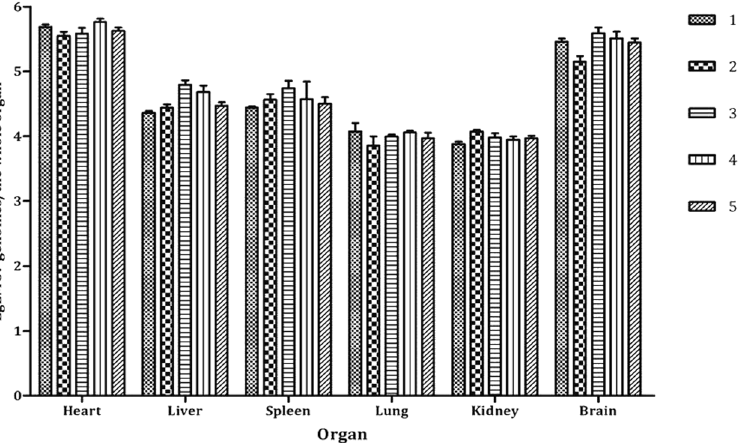
Figure 5. EMCV-C15 loads in the organs of artificially challenged dogs according to real-time RT-PCR. Viral loads in various organs are shown in the graph. Eight 25-to-30-day-old dogs were obtained from a commercial breeding herd that was free of CPV, CDV, CPIV, CHV, ICHV and EMCV. Dogs were randomly allocated into two groups. Dogs in group A (n = 5) were inoculated with 1.0 mL (10 5 TCID 50 ) of EMCV-C15. Dogs in group B (n = 3) were injected with 1.0 mL of DMEM as a control treatment. At 35 DPI, all dogs were euthanized and subjected to analysis of viral loads/virus distribution of EMCV-C15. Numbers 1, 2, 3, 4 and 5 in the legend correspond to the five dogs inoculated with EMCV-C15. Data from group B (uninfected group) are not visible in the graph because there was no viral load in animals from that group. Error bars represent the standard error of the mean of three replicates.